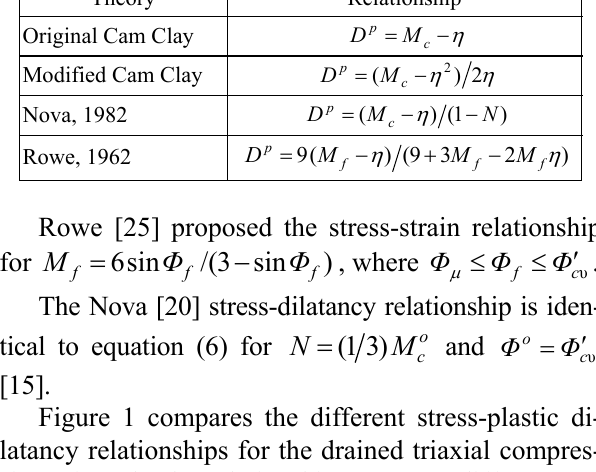
Fig. 2. Relationship between and the strain increment ratio at